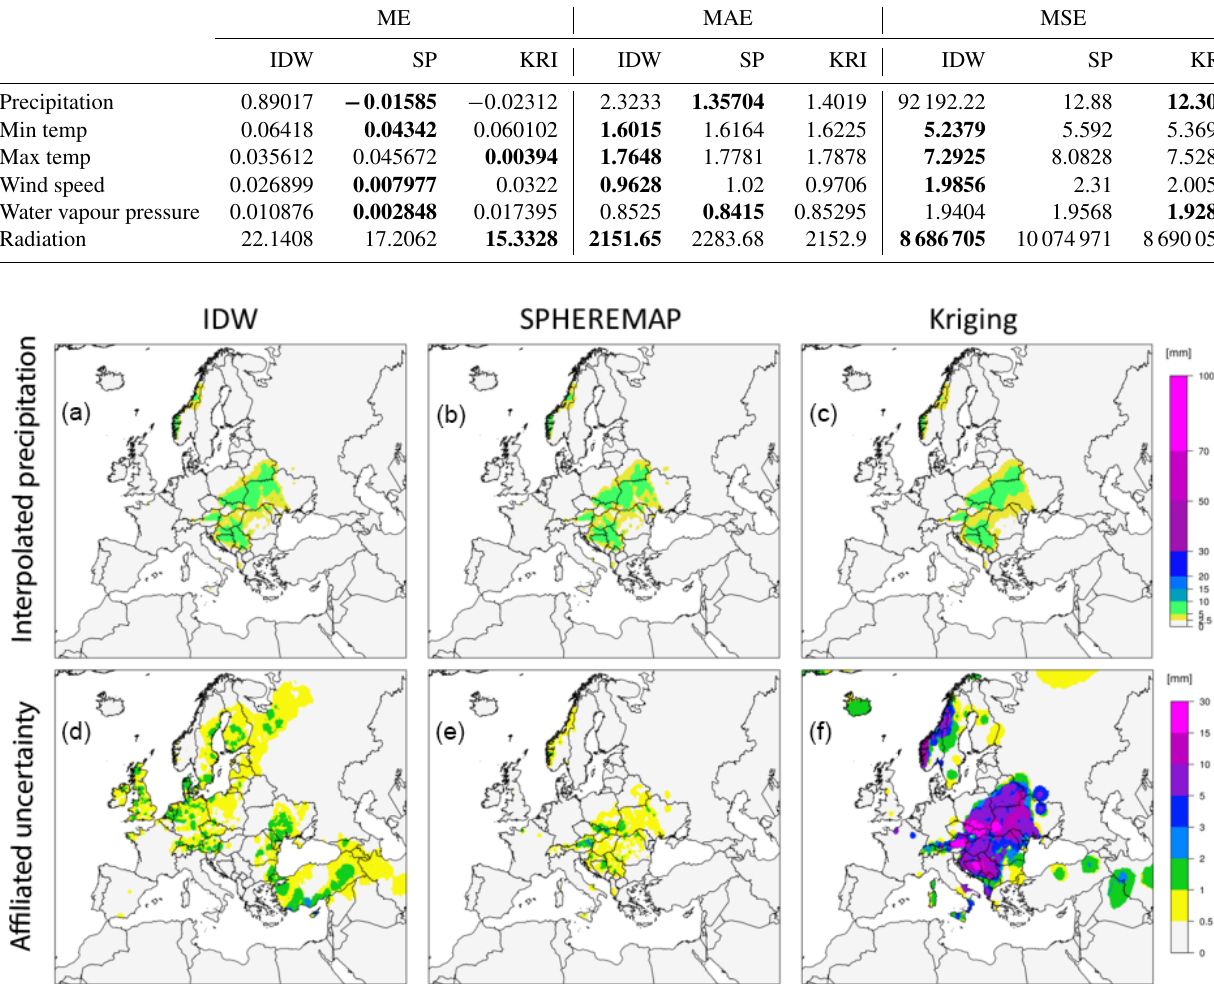
Table 5. Summary of the error measures for the three interpolation schemes based on the leave-one-out analysis (best values are in bold).